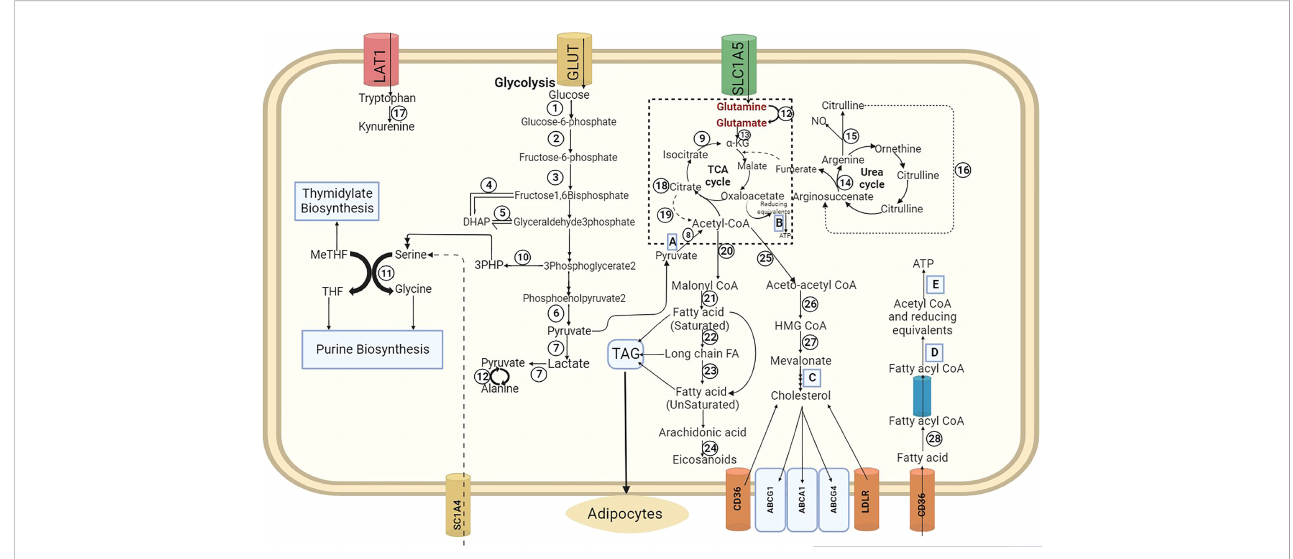
FIGURE 1 Overview of Carbohydrate, Amino acid, Fatty acid metabolism-hexokinase, phosphor-glucose isomerase, phosphofructokinase, aldolase, triose phosphate isomerase, pyruvate kinase, lactate dehydrogenase, pyruvate dehydrogenase, isocitrate dehydrogenase, phosphoglycerate dehydrogenase, serine hydroxymethyl transferase, transaminase, glutamate dehydrogenase, arginosuccinate lyase, nitric oxide synthase, arginosuccinate synthase, IDO/ TDO, citrate synthase, ATP citrate lyase, acetyl-CoA carboxylase, fatty acid synthase, elongase, desaturase, cyclooxygenase (1 and 2), acetyl-CoA acyl transfers, HMG CoA synthase, HMG CoA reductase, fatty acyl CoA synthase. (A) mitochondrial pyruvate carrier, (B) electron transport chain, (C) cholesterol synthesis, (D) b -Oxidation, (E) oxidative